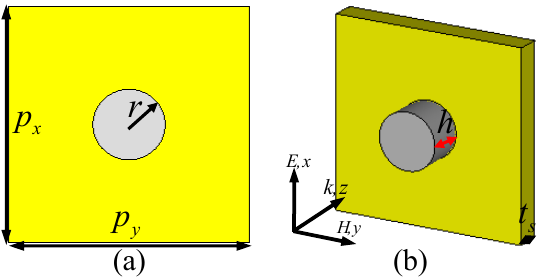
Figure 1. Schematic of the single-band plasmonic perfect absorber (PPA): ( a ) the front and ( b ) perspective view of the unit-cell nanostructure.